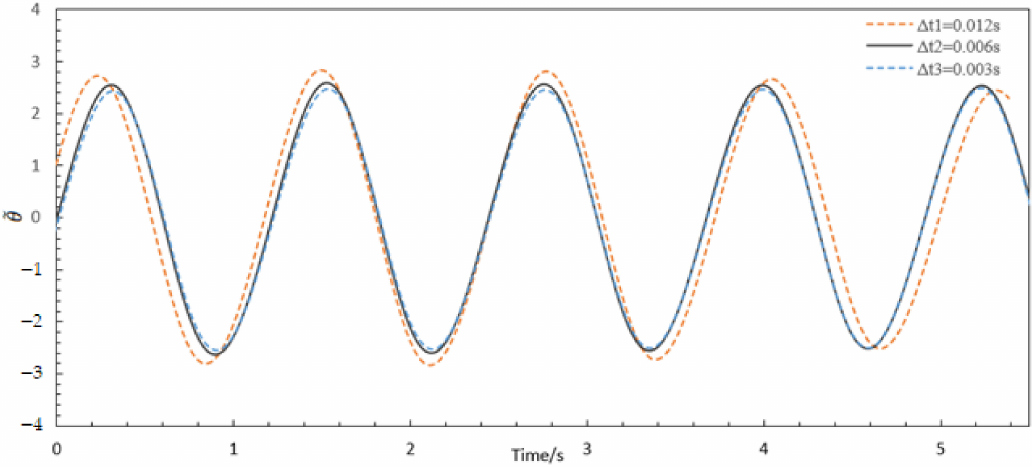
Figure 10. Time histories of (cid:101) θ of the ship obtained on grid 2 from simulations with three different time steps.